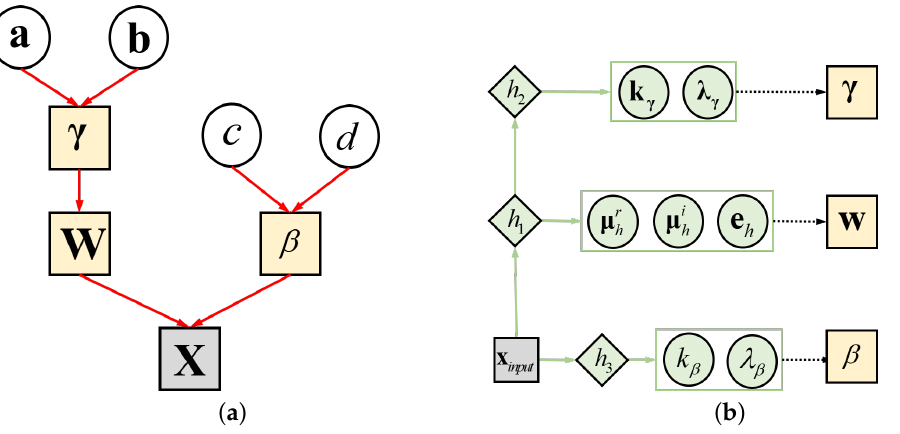
Figure 2. The structure of BAMCV. ( a ) Generative model of BAMCV. ( b ) Inference network of BAMCV. The red arrows denote the data generation. The green arrows denote the information propagation in the inference network. The black arrows with imaginary lines represent reparameterization